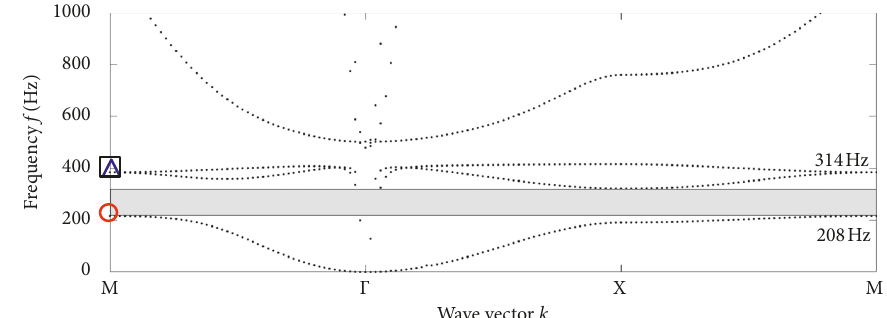
Figure 9: Dispersion curve under type